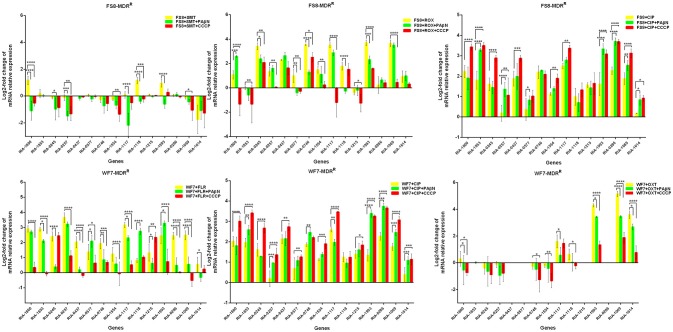
Quantification of the relative mRNA expression levels of a panel of EPGs in multidrug-resistant strains. Strains were grown in the presence of half MIC of each antibiotic; CCCP (5 μg/mL) and PAβN (40 μg/mL) showed no effects on the growth of R. anatipestifer isolates. The MICs of the antibiotics and EPIs were determined for each strain and are presented in Table 4. Change in the level of transcription of EPGs was measured as fold change normalized to recA gene expression and was subsequently calculated as log2-fold change that is relative to the untreated cell culture. Levels of significance were set as follows: *P < 0.05 was considered statistically significant, and **P < 0.01, ***P < 0.001, and ****P < 0.0001 were all considered highly significant.